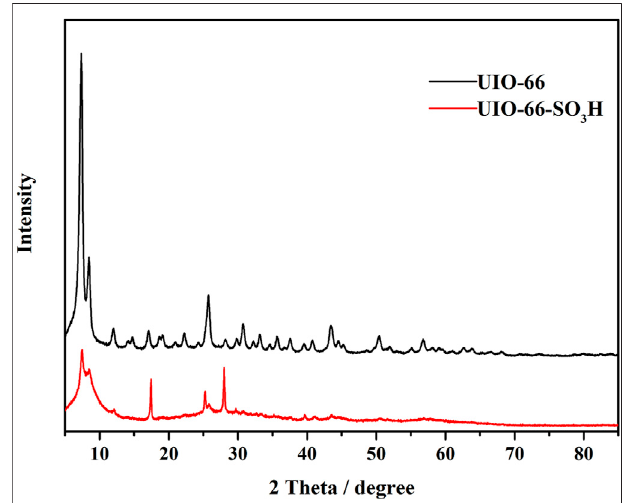
FIGURE 3 | XRD patterns of UIO-66 and UIO-66-SO 3